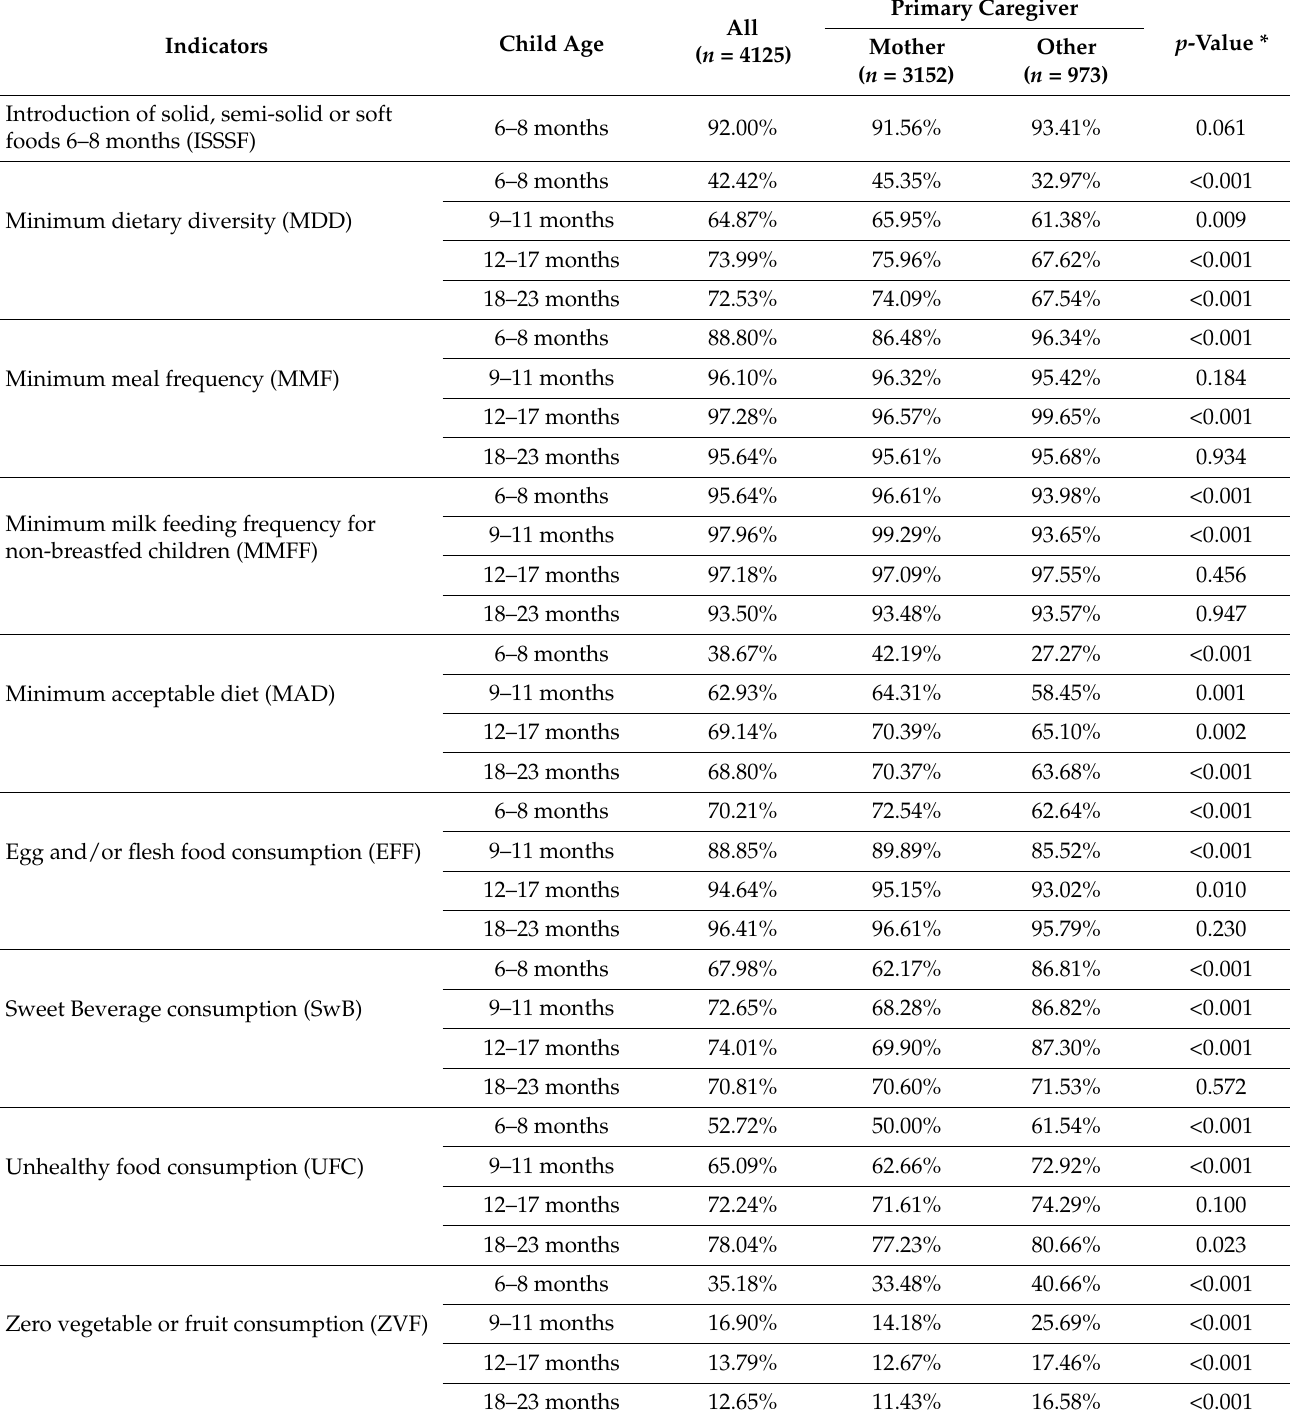
Table 3. Percentage of children who met the complementary feeding indicators according to their age range and primary caregivers ( n =